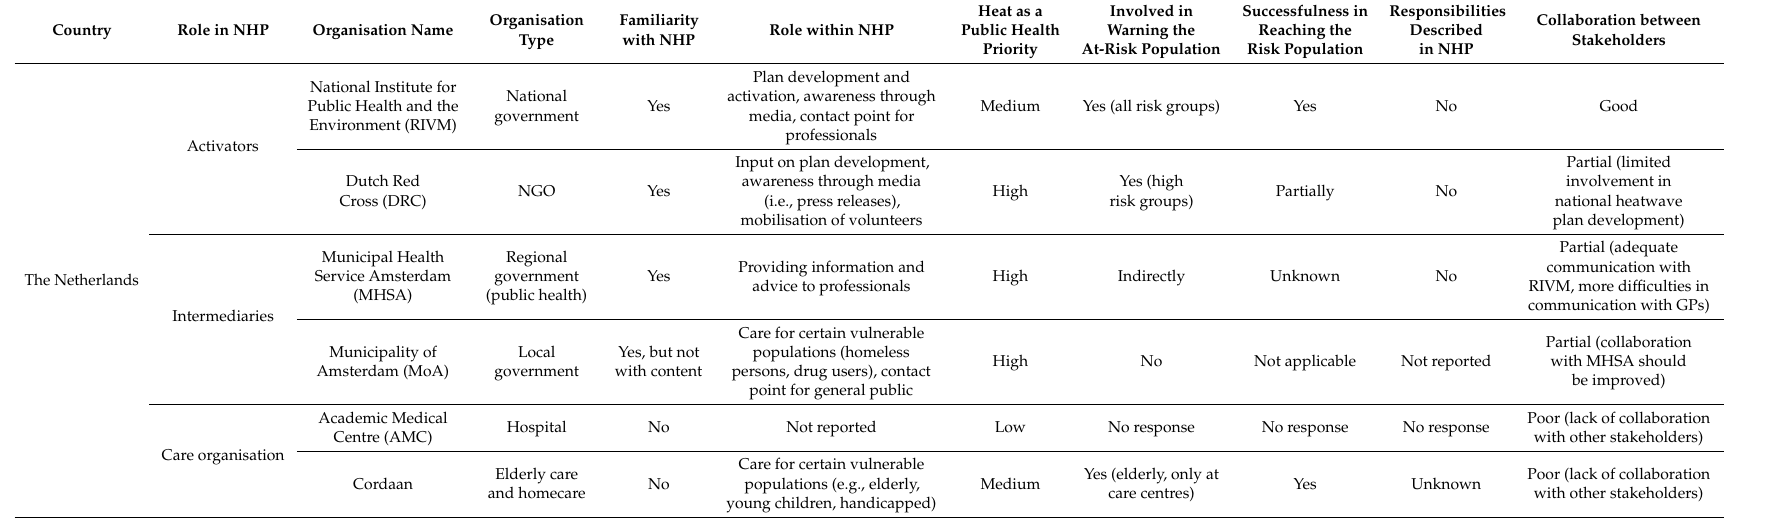
Table 3. Overview of interviews with selected key informants in The